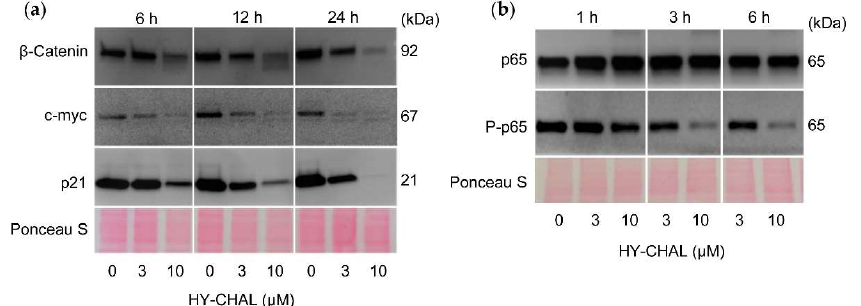
Figure 6. HY-CHAL downregulated β-catenin, c-myc and p21 Cip1/WAF1 , and inhibited NF-κB. ( a , b ) Cells were treated with the specified concentrations of HY-CHAL for the indicated times and cell lysates were probed with the specified antibod- ies. Equal loading was controlled by staining the membrane with Ponceau